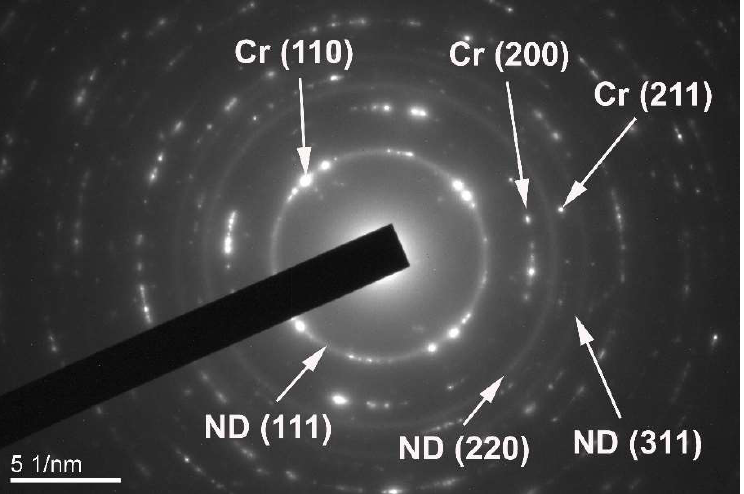
Figure 3. Electron diffraction pattern obtained when examining the composite (chromium + 15% nanodiamonds by volume).